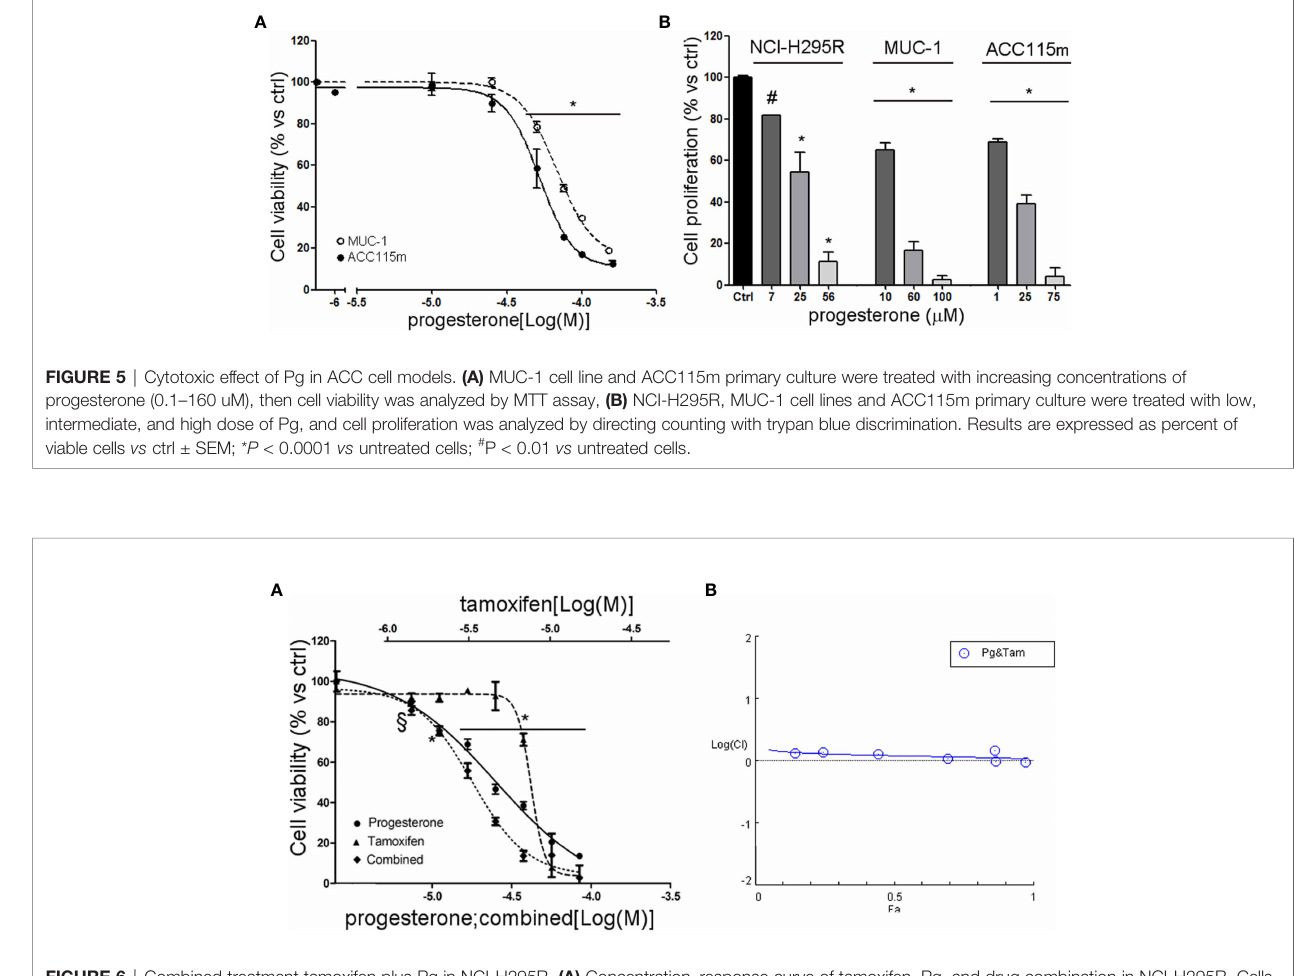
FIGURE 6 | Combined treatment tamoxifen plus Pg in NCI-H295R. (A) Concentration – response curve of tamoxifen, Pg, and drug combination in NCI-H295R. Cells were exposed to increasing concentrations of tamoxifen and Pg alone or in combination as described in Materials and Methods . Data are expressed as percent of viable cells vs ctrl. Data are the mean ± SEM of three independent experiments; * P < 0.0001 vs untreated cells; § P < 0.001 vs untreated cells. (B) Combination index plot. Cell viability data of panel A were converted to Fa values and analyzed with CompuSyn software.